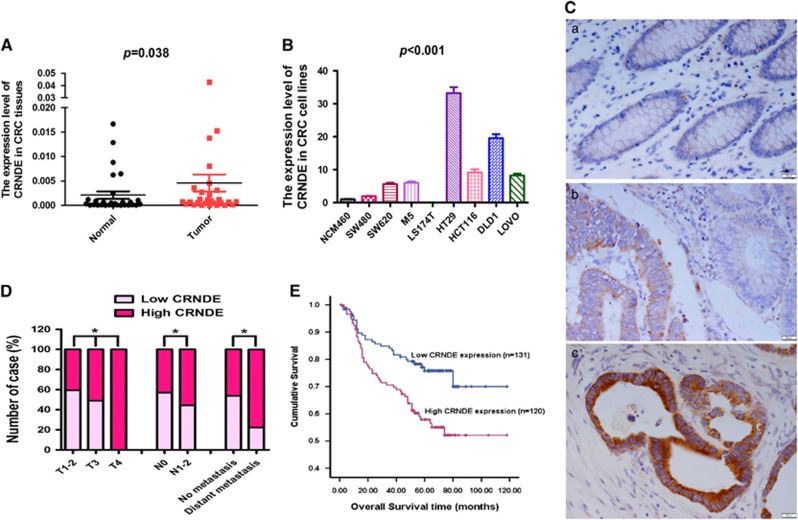
CRNDE expression is upregulated in CRC and could be an independent prognostic factor for the prediction of the overall survival of CRC patients. (A) Expression levels of CRNDE in paired CRC and adjacent non-cancerous tissues. (B) Expression levels of CRNDE in CRC and colon mucosa epithelial (NCM460) cell lines. (C) Expression analysis of CRNDE in normal colorectal mucosa and CRC tissues by ISH. (a) Negative expression of CRNDE in normal colorectal mucosa. (b) High expression of CRNDE in a tumor tissue sample and weak expression of CRNDE in its normal mucosal counterpart were observed in one filed of a tissue sample from a single patient. (c) High expression of CRNDE in CRC tissue. Scale bars are shown in the lower right corner of each picture. (d) Graphical illustration of statistical CRNDE distribution in CRC patients. (E) Kaplan–Meier analysis of overall survival in all patients with CRC according to CRNDE expression. *P<0.05